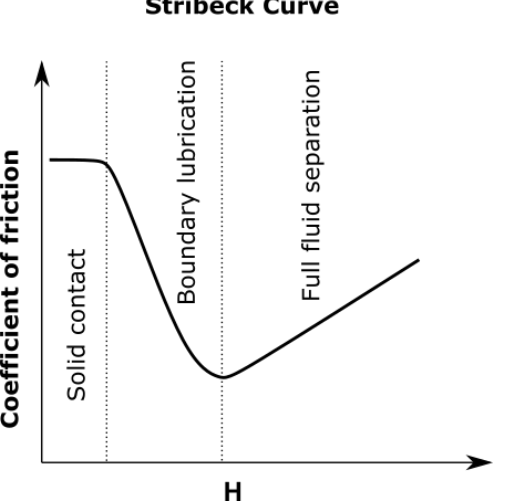
Figure 1. Stribeck curve; coefficient of friction against the Hersey number in the three lubrication